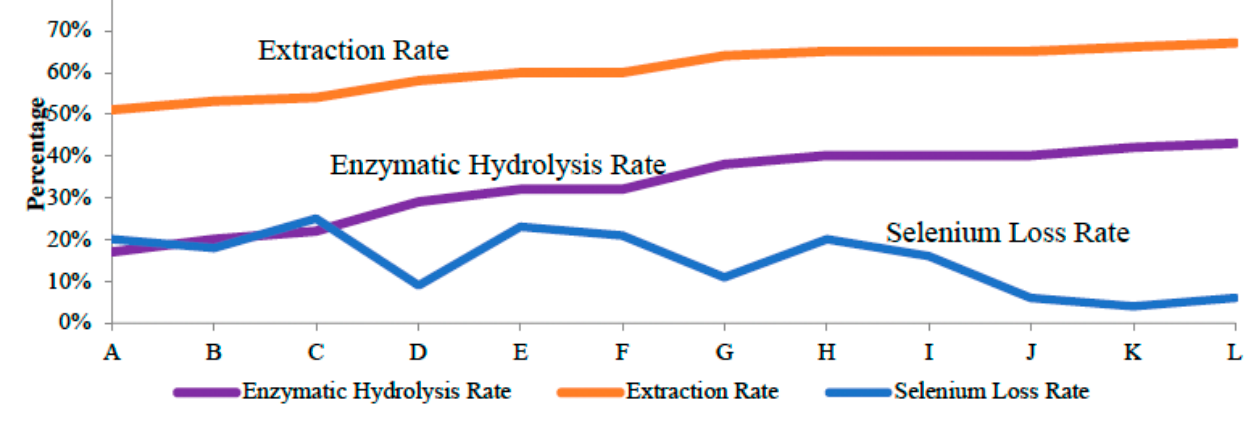
Figure 2. The extraction rate, enzymatic hydrolysis rate, and loss rate on Se for high Se-enriched Ganoderma lucidum under 12 sequential extraction methods. Note: A-Phosphate (pH 7.5), trypsin; B-Phosphate (pH 7.5), protease XIV; C-Tris-HCl (pH 7.5), trypsin; D-Tris-HCl (pH 7.5), protease XIV; E-Tris-HCl (pH 7.5), protease K; Phosphate (pH 7.5), protease XIV; F-Tris-HCl (pH 7.5), protease K; Tris-HCl (pH 7.5), protease XIV; G-Glycine (pH 2.1), pepsin; Phosphate (pH 7.5), trypsin; H-Phosphate (pH 7.5), protease K; Phosphate (pH 7.5), protease XIV; I-Phosphate (pH 7.5), protease K; Tris-HCl (pH 7.5), protease XIV; J-Glycine (pH 2.1), pepsin; Tris-HCl (pH 7.5), trypsin; K-Tris-HCl (pH 2.1), pepsin; Phosphate (pH 7.5), trypsin; L-Tris-HCl (pH 2.1), pepsin; Tris-HCl (pH 7.5), trypsin. Extraction rate (%) =